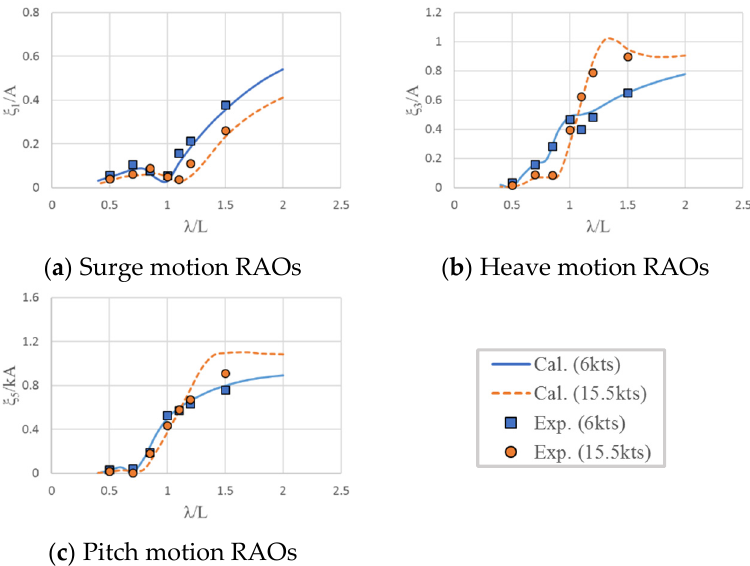
Figure 9. Motion response amplitude operators (RAOs) of KVLCC2: β = 180°, H/L = 1/50.